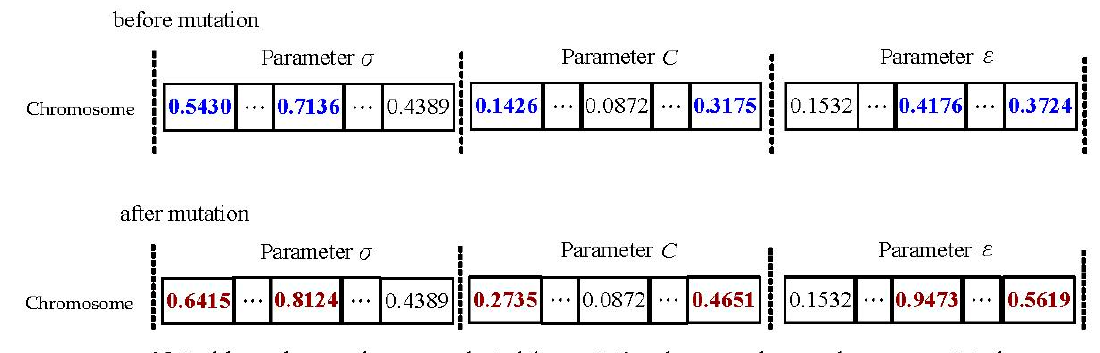
Figure 3. Example of the chromosome form of the parameters for the quantum crossover operation.